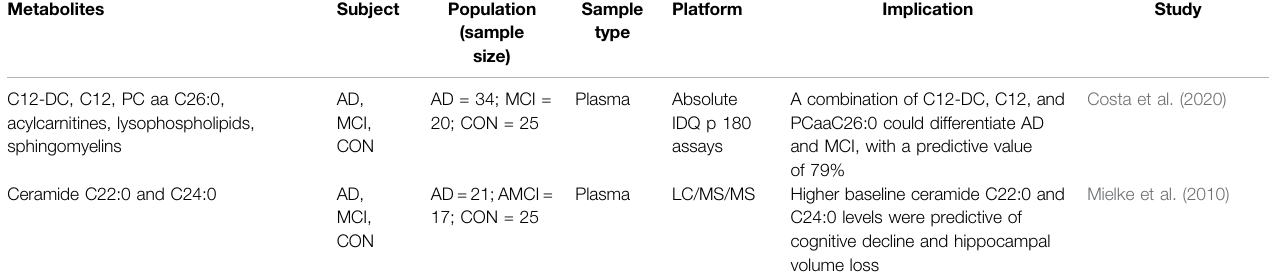
TABLE 2 | ( Continued ) Metabolic biomarker in blood for Alzheimer ’ s disease patients in clinical.